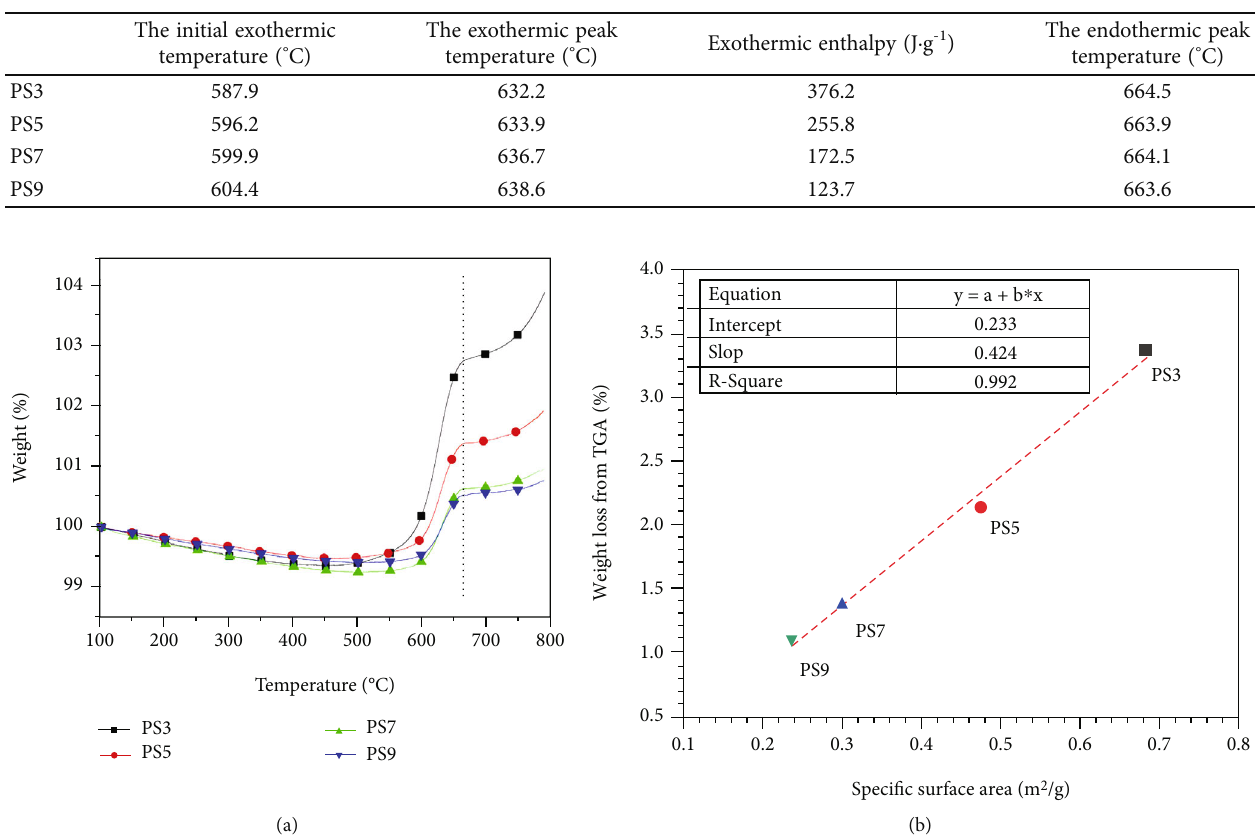
Table 3: DSC temperature parameters of di ff erent aluminum